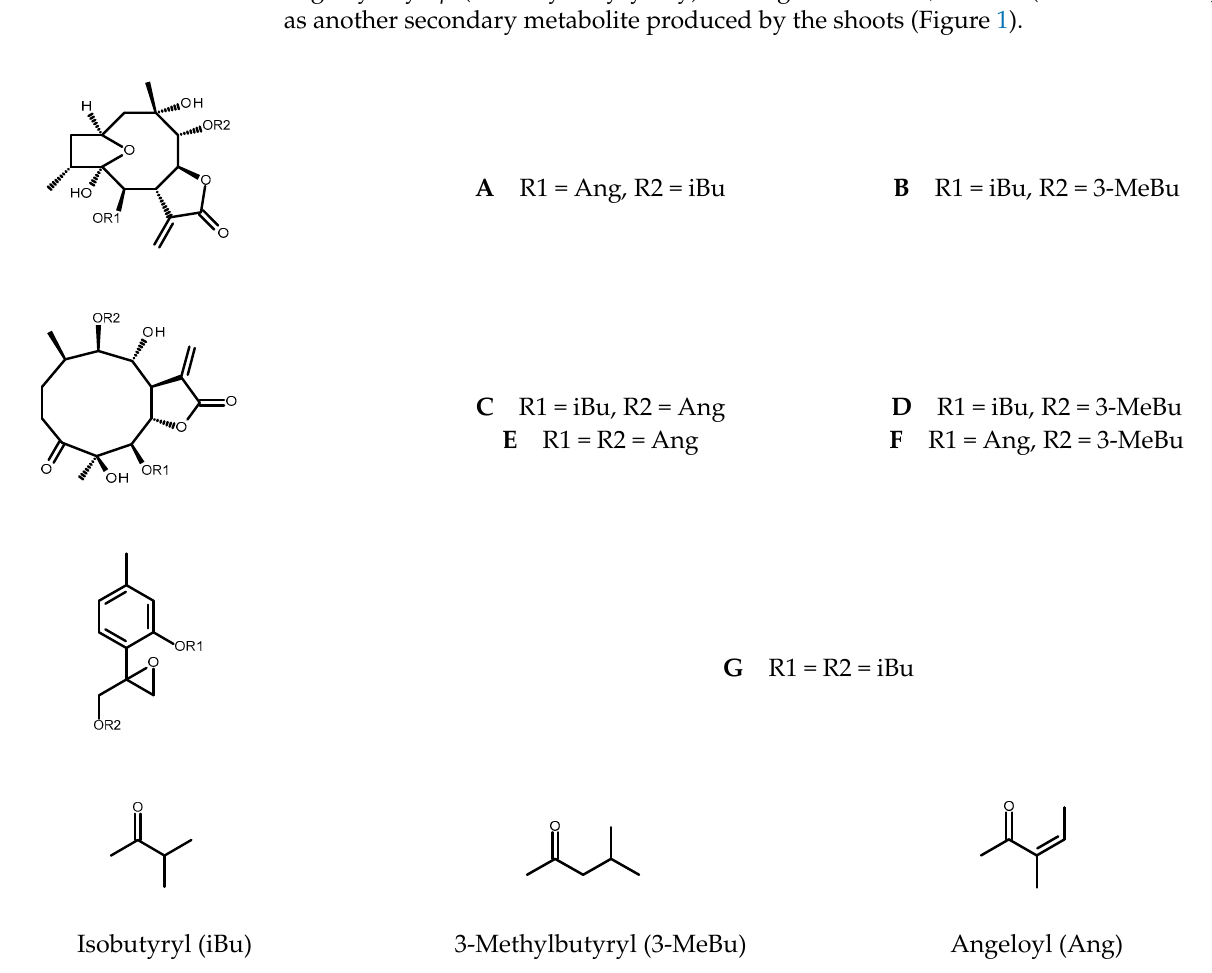
Figure 1. Chemical structures of the terpenoids identified in C. divaricatum extracts: isocardivarolide C ( A ); 2 α ,5-epoxy-5,10-dihydroxy-6 α -isobutyryloxy-9 β -(3-methylbutyryloxy)-germacran-8 α ,12-olide ( B ); cardivarolide H ( C ); 4 β ,8 α -dihydroxy-5 β -isobutyryloxy-9 β -(3-methylbutyryloxy)-3-oxo-germacran-6 α ,12-olide ( D ); cardivarolide F ( E ); cardivarolide G ( F ) and 10-isobutyryloxy-8,9-epoxythymyl isobutyrate ( G ).